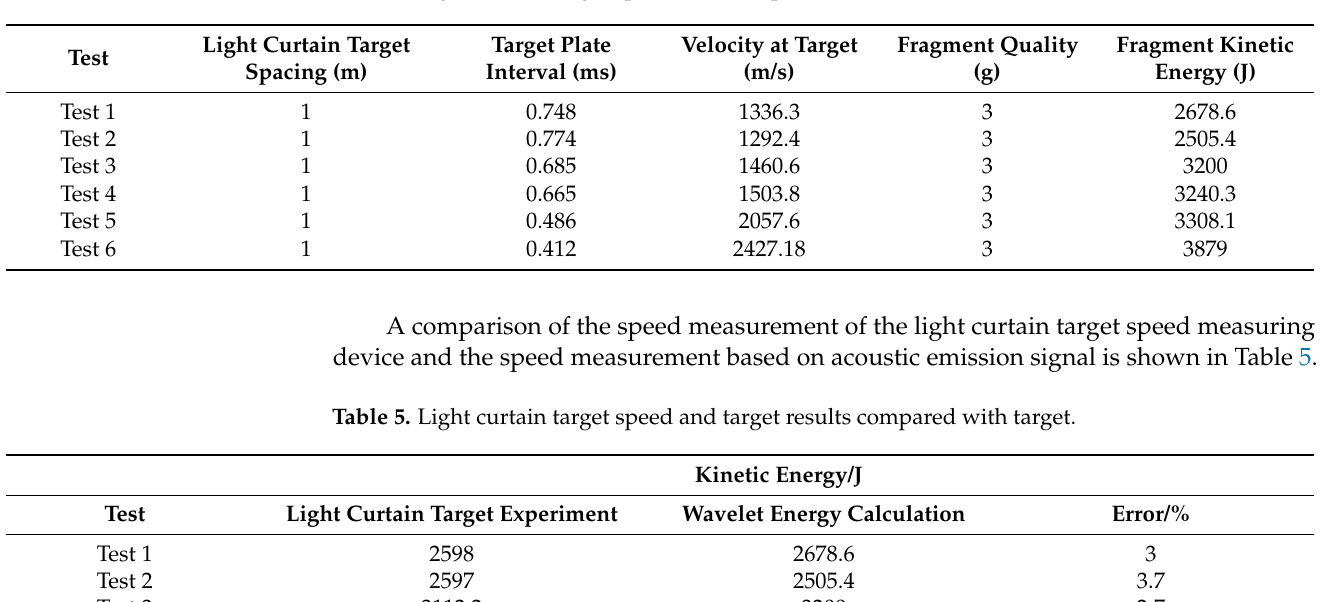
Table 4. Light curtain target speed device experiment.